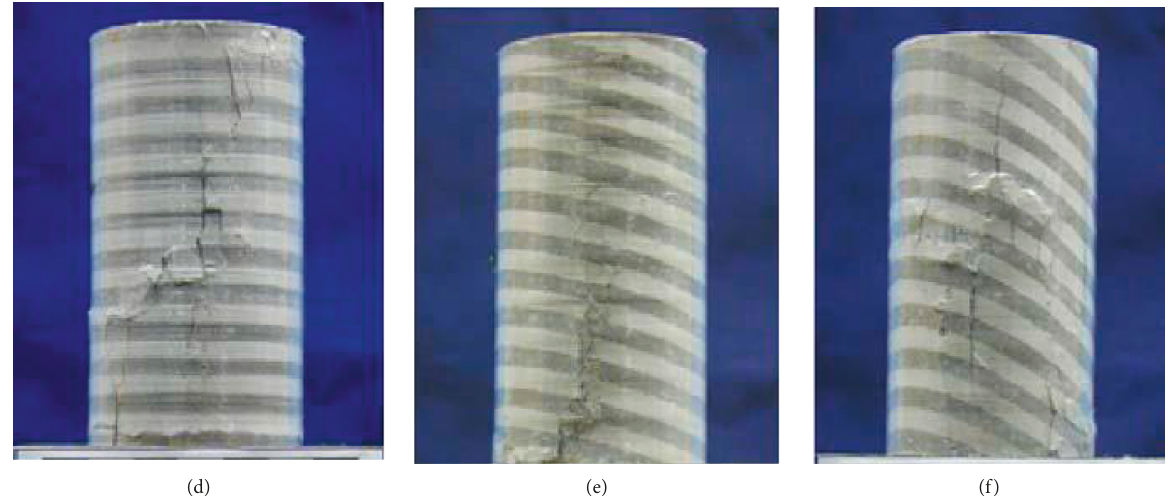
Figure 19: Failure modes for specimens with different layer orientations under uniaxial compression observed in laboratory (from Tien et al. [6]): (a) α